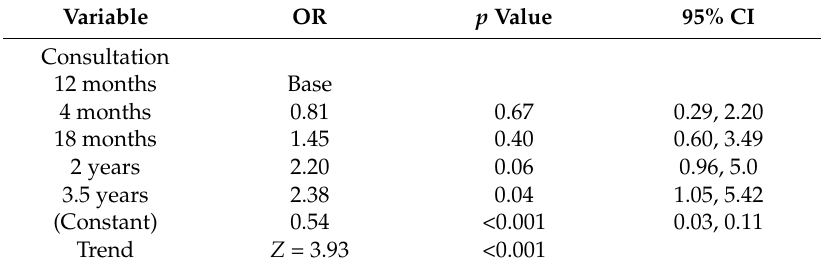
Table 2. Logistic regression model estimating effects of key consultations on weight status. Variable OR p